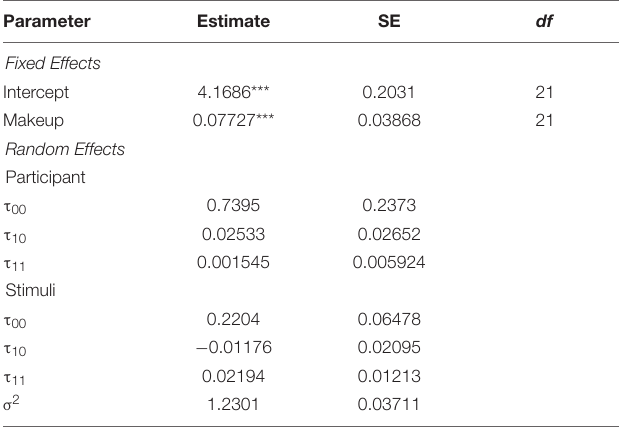
TABLE 2 | Parameter estimates for multilevel model predicting Competence ratings from Makeup